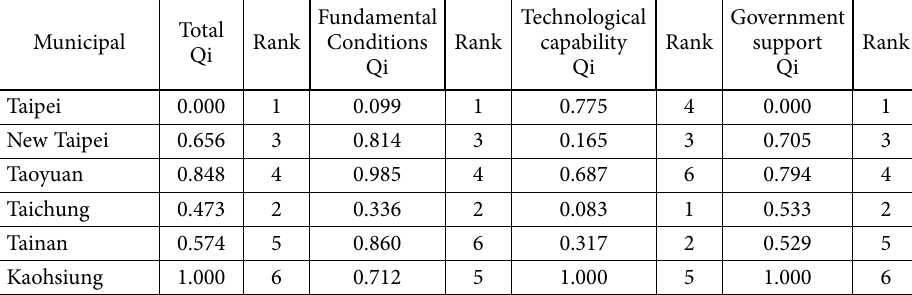
Table 7. Innovation and technology capabilities for the six metropolitan areas-18 Res. Inst. experts Municipal Taipei Taoyuan Taichung